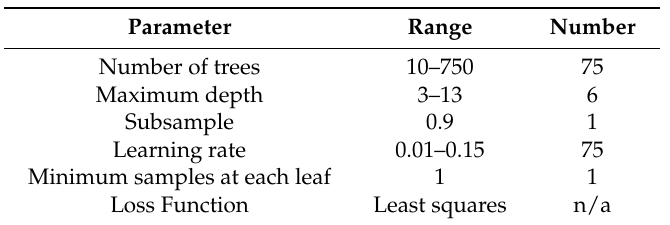
Table 3. Parameters of a gradient boosting regression and parameter values tested to find the best model. ‘Range’ specifies the maximum and minimum values of the parameter and number specifies the number of different values within that range that were